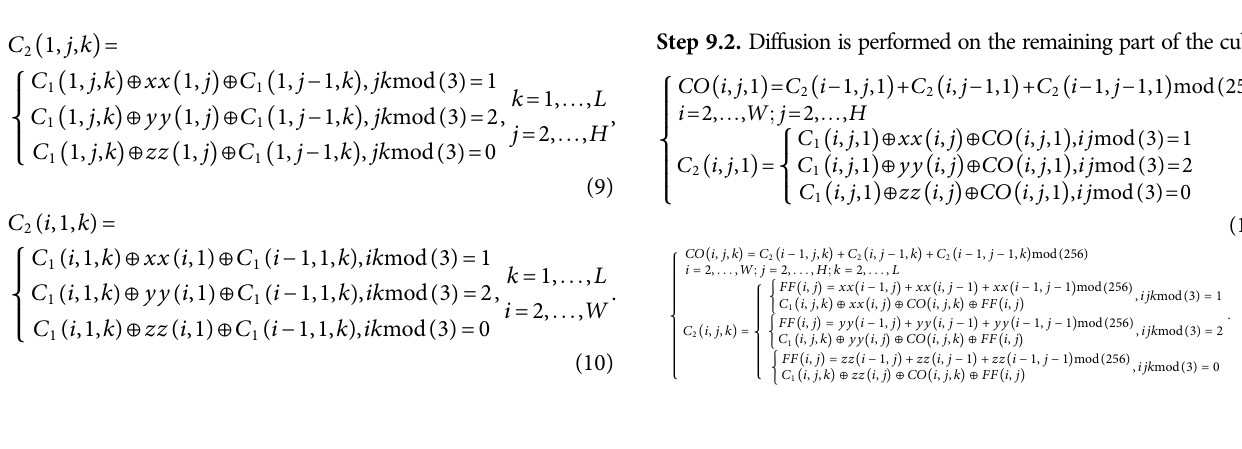
Frontiers in Physics |